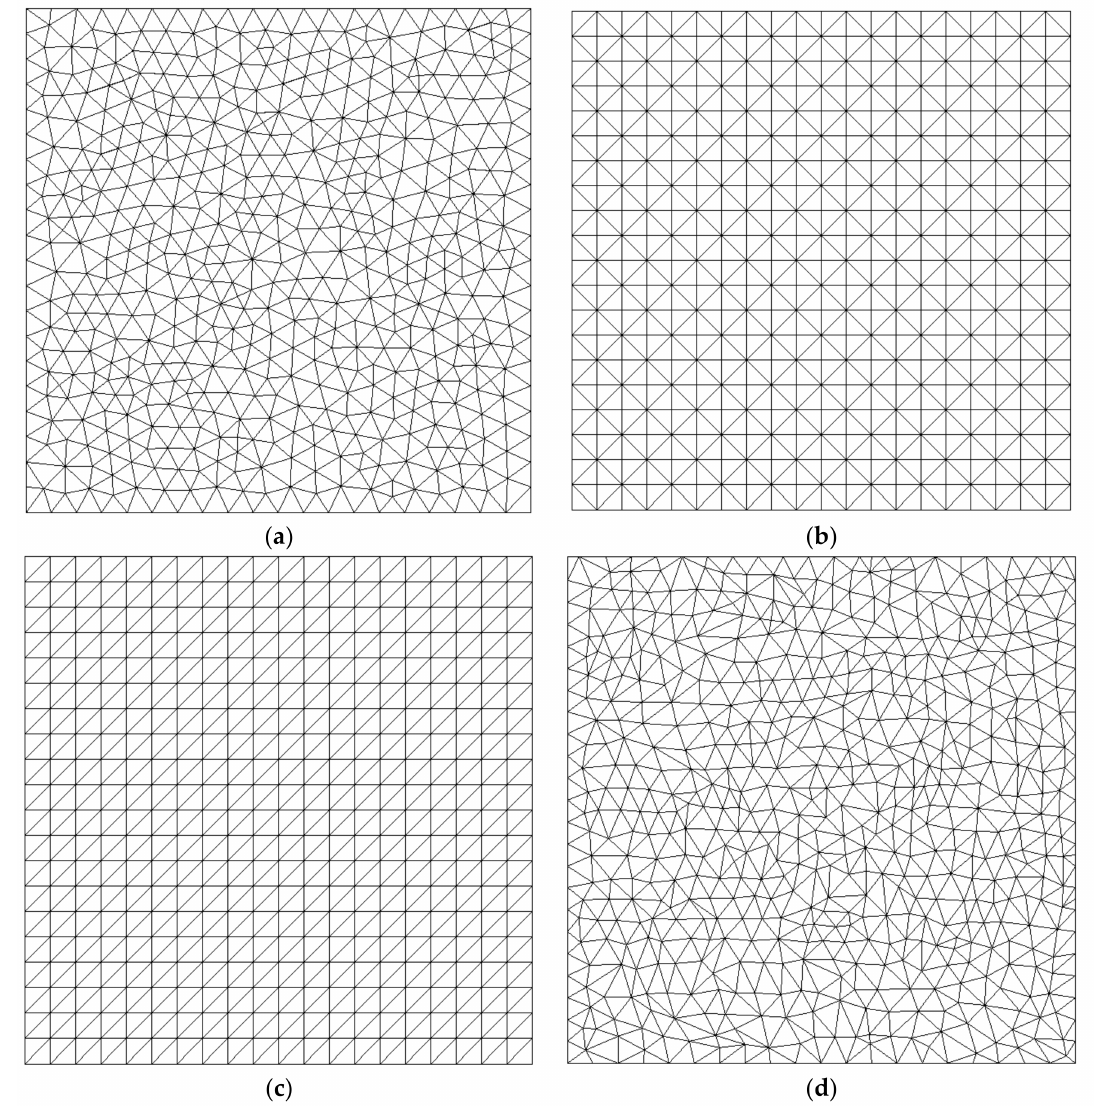
Figure 15. Four triangular mesh types used for computation: ( a ) Delaunay; ( b ) orthogonal-I; ( c ) orthogonal-II; ( d )